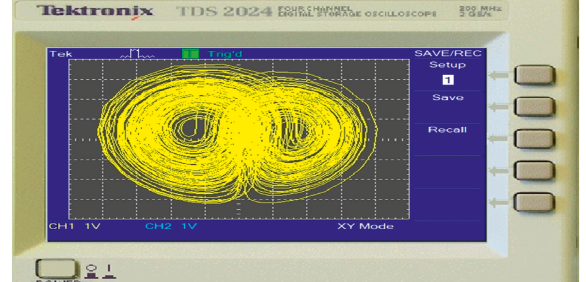
Figure 31: Electronic circuit simulation using MultiSim 14.0 for the new hyperchaotic two-scroll circuit (42) in the ( Z ordinate plane.